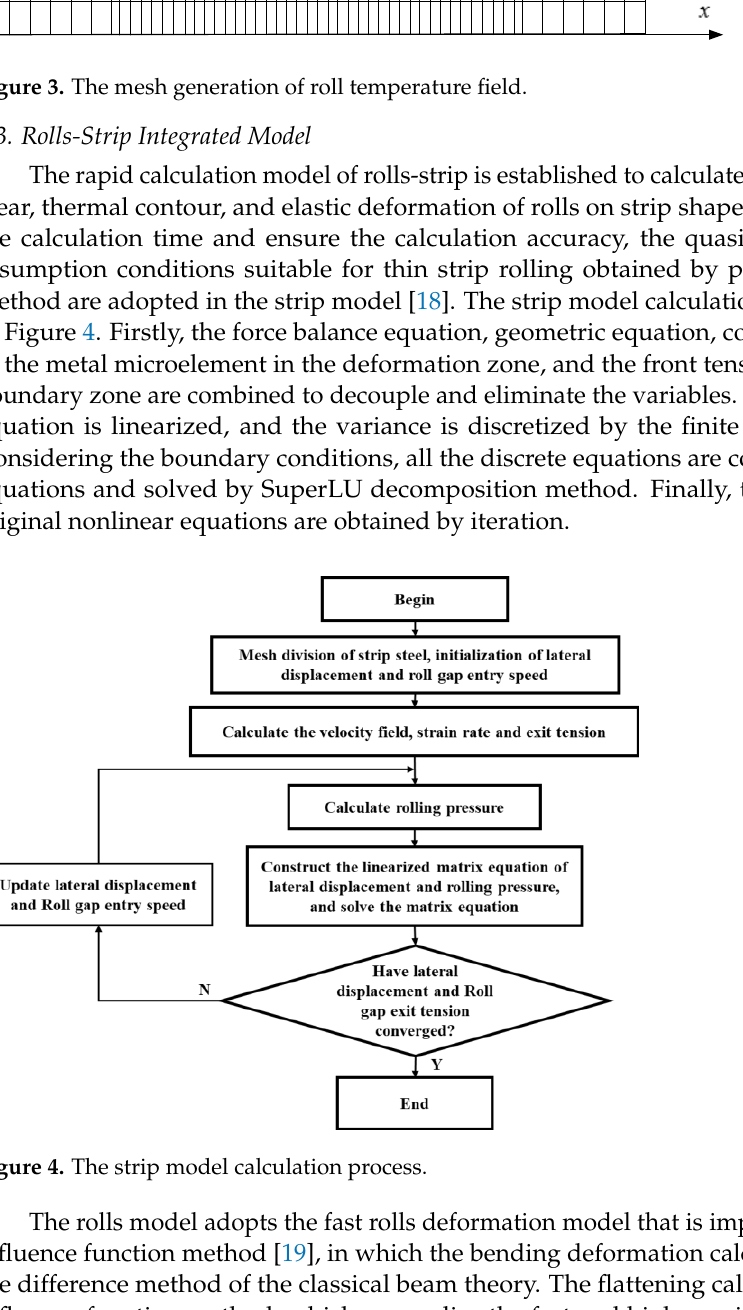
Figure 3. The mesh generation of roll temperature field.